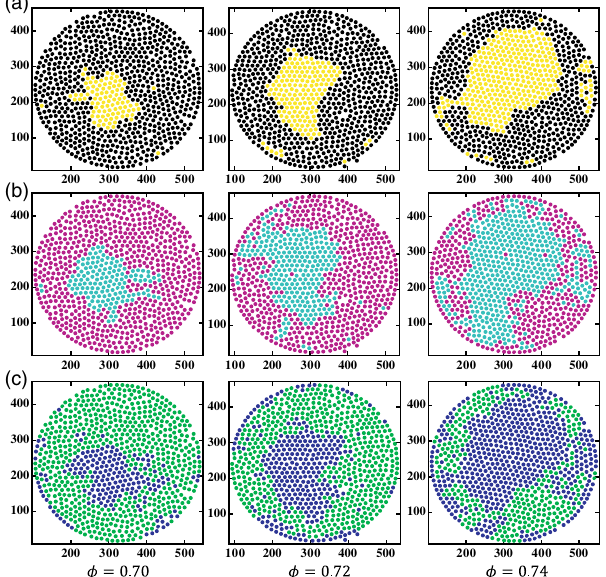
FIG. 4. Continuous and discontinuous nature of the phase transition, respectively, in steel and rubber ball systems. Blue FIG. 5. Liquid-solid coexistence for rubber ball systems curves and symbols are for a steel ball system, whereas red ones observed at ϕ ¼ 0 . 70 , 0.72, and 0.74, which are between are for a rubber ball system. (a) The divergence of the correlation ϕ ð¼ 0 . 695 Þ and ϕ ð¼ 0 . 775 Þ , as Γ ¼ 3 . 3 . The two-phase coex- length of the hexatic order ξ 6 (filled circle) towards the hexatic L S istence can be seen by binarization by using the following three ordering point ϕ and that of the translational order ξ (open h quantities.(a)Thehexaticorderparameter ψ 6 ofeachparticle[here, circle) towards the solidification point ϕ for a steel ball system. s thethresholdischosenas ψ th 6 ¼ 0 . 6 ,andthepatternisinsensitive to The solid and dashed curves are the prediction of the KTHNY the choice for ϕ ¼ 0 . 6 – 0 . 7 (see Fig. 6)]. Yellow (solid) and black theory (see Fig. 1). (b) The ϕ dependence of ξ 6 (filled circle) and (liquid) particles correspond to particles having ψ 6 ≥ ψ th 6 and ξ (open circle) for a homogeneous liquid state of a rubber ball ψ ψ th ρ , which is calculated 6 < 6 , respectively. (b) The local density system. (c) The susceptibility of the hexatic order parameter χ 6 from the Voronoi area of each particle (the threshold for steel (blue filled circle) and rubber ball systems (red filled 1 = ρ th ¼ 9 . 4 mm 2 ). Blue-green (solid) and pink (liquid) particles circle). The steep increase near ϕ is observed for a steel ball h correspond to particles having ρ ≥ ρ th and ρ < ρ th , respectively. system, reflecting the nearly continuous nature of the transition, (c) The displacement over 10 s of each particle (the threshold whereas there is no such behavior for a rubber ball system, δ th ¼ 3 . 4 mm).Blue(solid) andgreen(liquid)particlescorrespond reflecting the strong discontinuous nature of the transition. toparticleshaving δ ≤ δ th and δ > δ th ,respectively.We canseethat (d) The area fraction of the solid phase to the total area, the solid regions identified by these three quantities are well A =A , as a function of ϕ . It starts to increase from ϕ until S L correlated with each other. We can also see the monotonic increase ϕ in proportion to ϕ − ϕ , indicating the validity of the lever S L of the solid fraction with an increase in ϕ rule. We also confirm the similar relation between the number of particles of the solid phase N and the total number of particles N . S This means that each coexistence phase retains the same number densities irrespective of ϕ in the coexistence region. The error bars in (a) – (c) represent the standard deviations of the fittings. For all the data, Γ ¼ 3 . 3 .